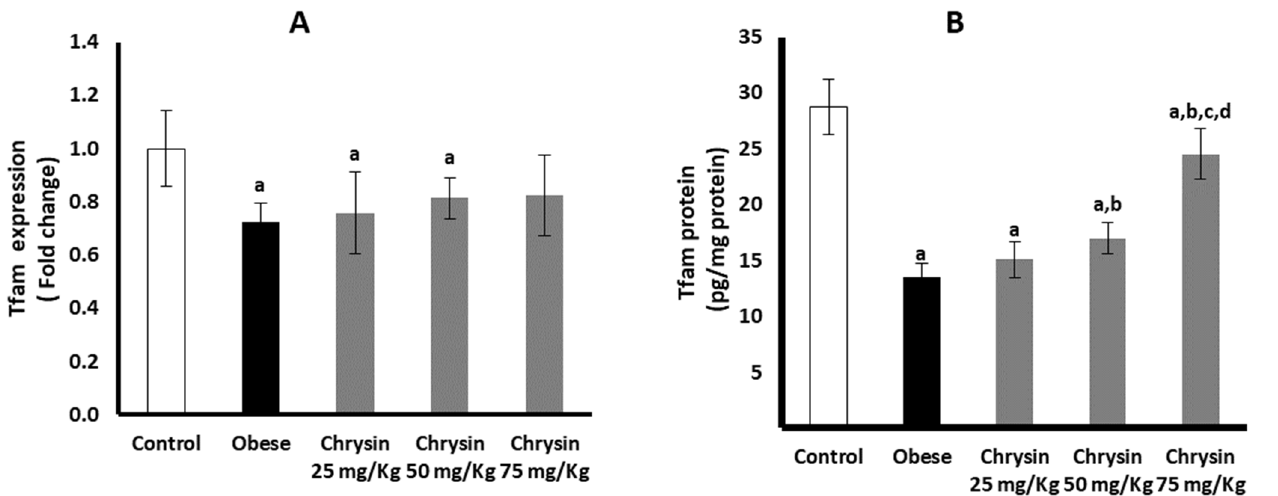
Figure 6. Changes in the hepatic expression of Tfam at mRNA ( A ) and protein ( B ) levels in the obese rats untreated or treated with different doses of chrysin. Data presented as Mean ± SD. a, significantly different from the control group; b, significantly different from the obese group; c, significantly different from the group treated with chrysin 25 mg/kg; d, significantly different from the group treated with chrysin 50 mg/kg, using ANOVA and p <